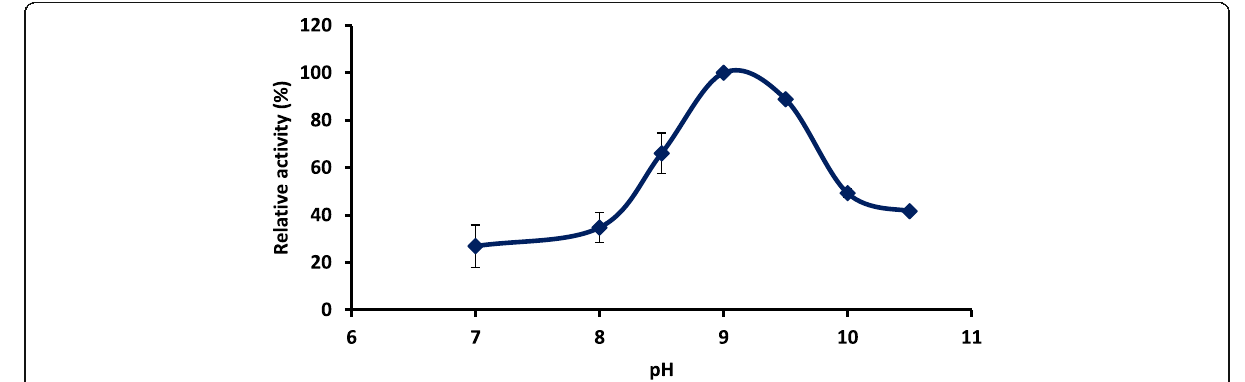
Fig. 3 Effect of variation of PEI pH on the catalytic activity of immobilized